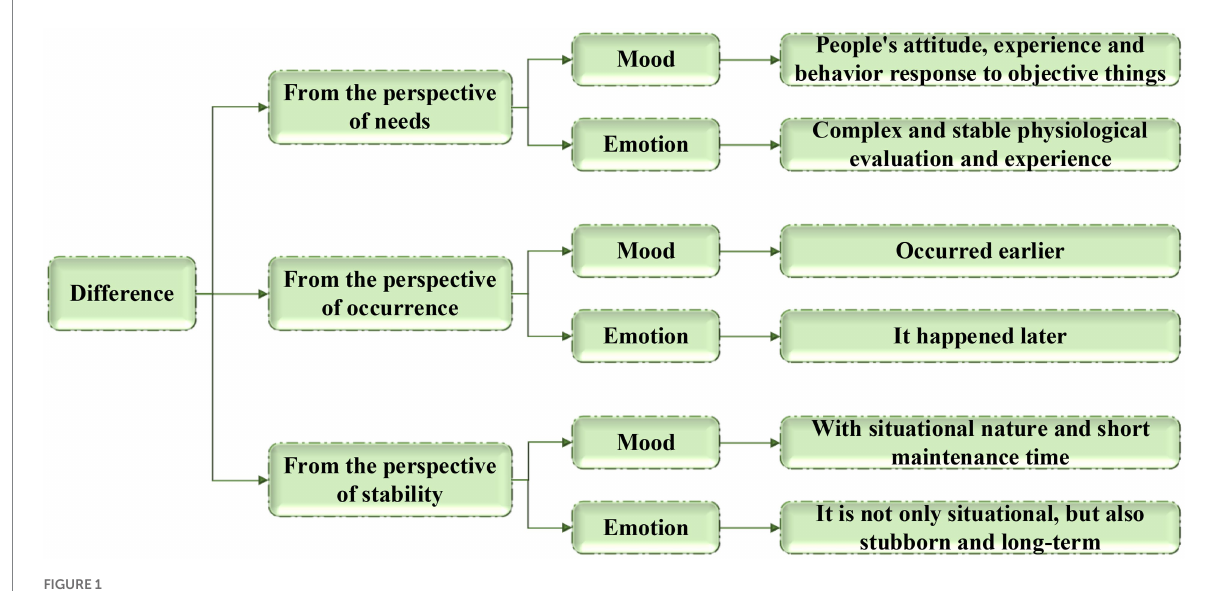
FIGURE 1 Difference between “moods” and